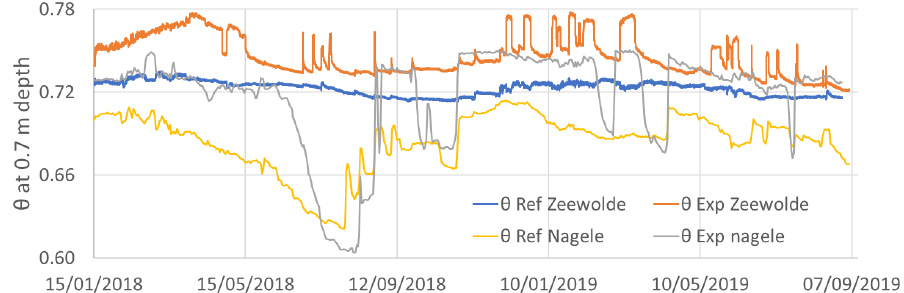
Figure 4. Variation in soil moisture content ( θ ) at 0.7m depth in peat for reference (Ref) and experimental (Exp) plots in Zeewolde and Nagele.